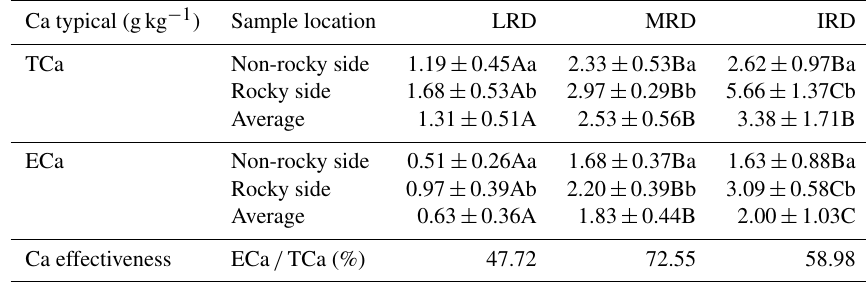
Table 2. Soil TCa and ECa content from different grades of rocky desertification.